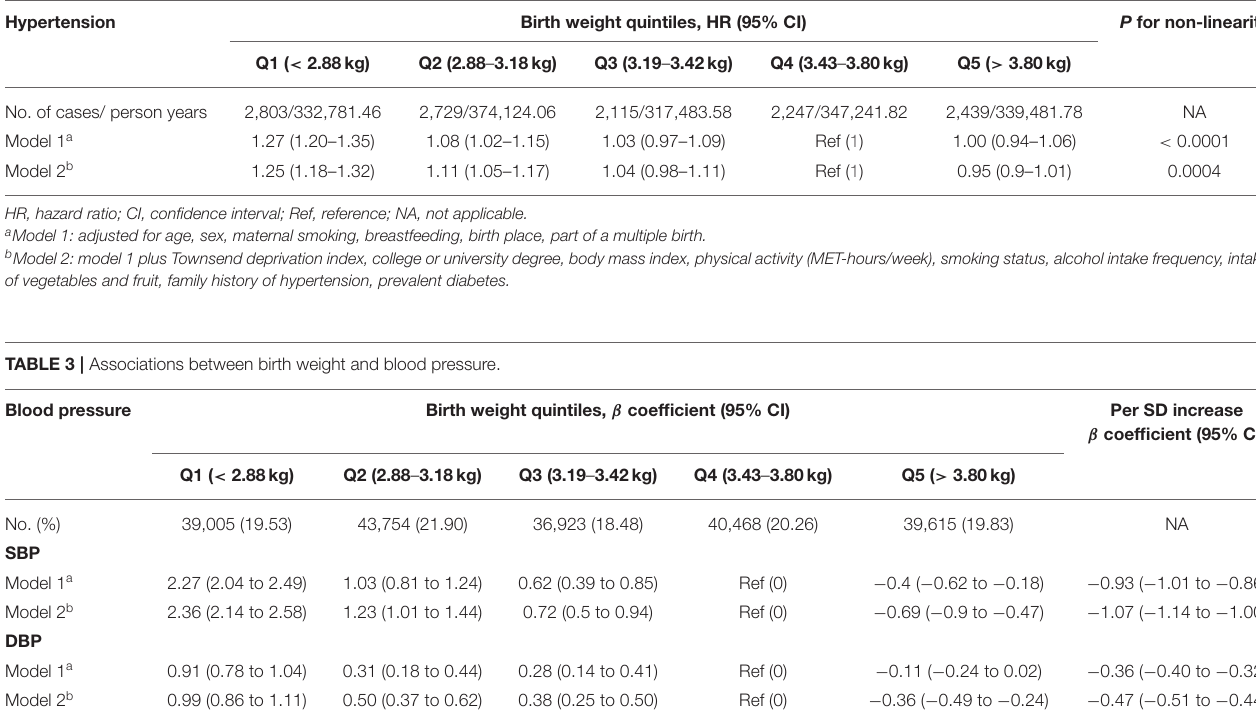
Frontiers in Cardiovascular Medicine |